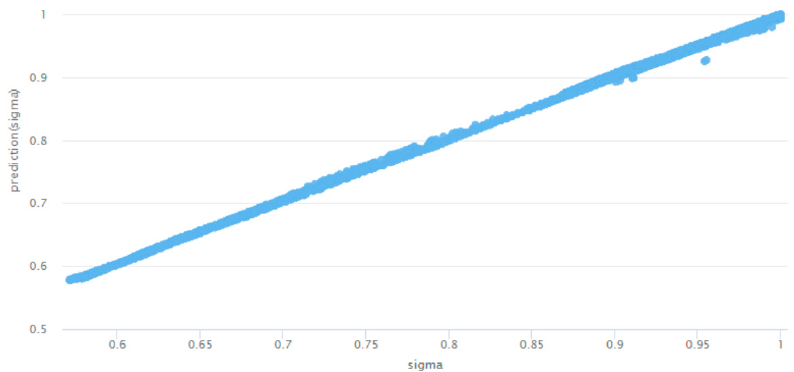
Figure 13. The prediction chart of the membership values of power dissipation (sigma) at design of summing and subtracting amplifier.